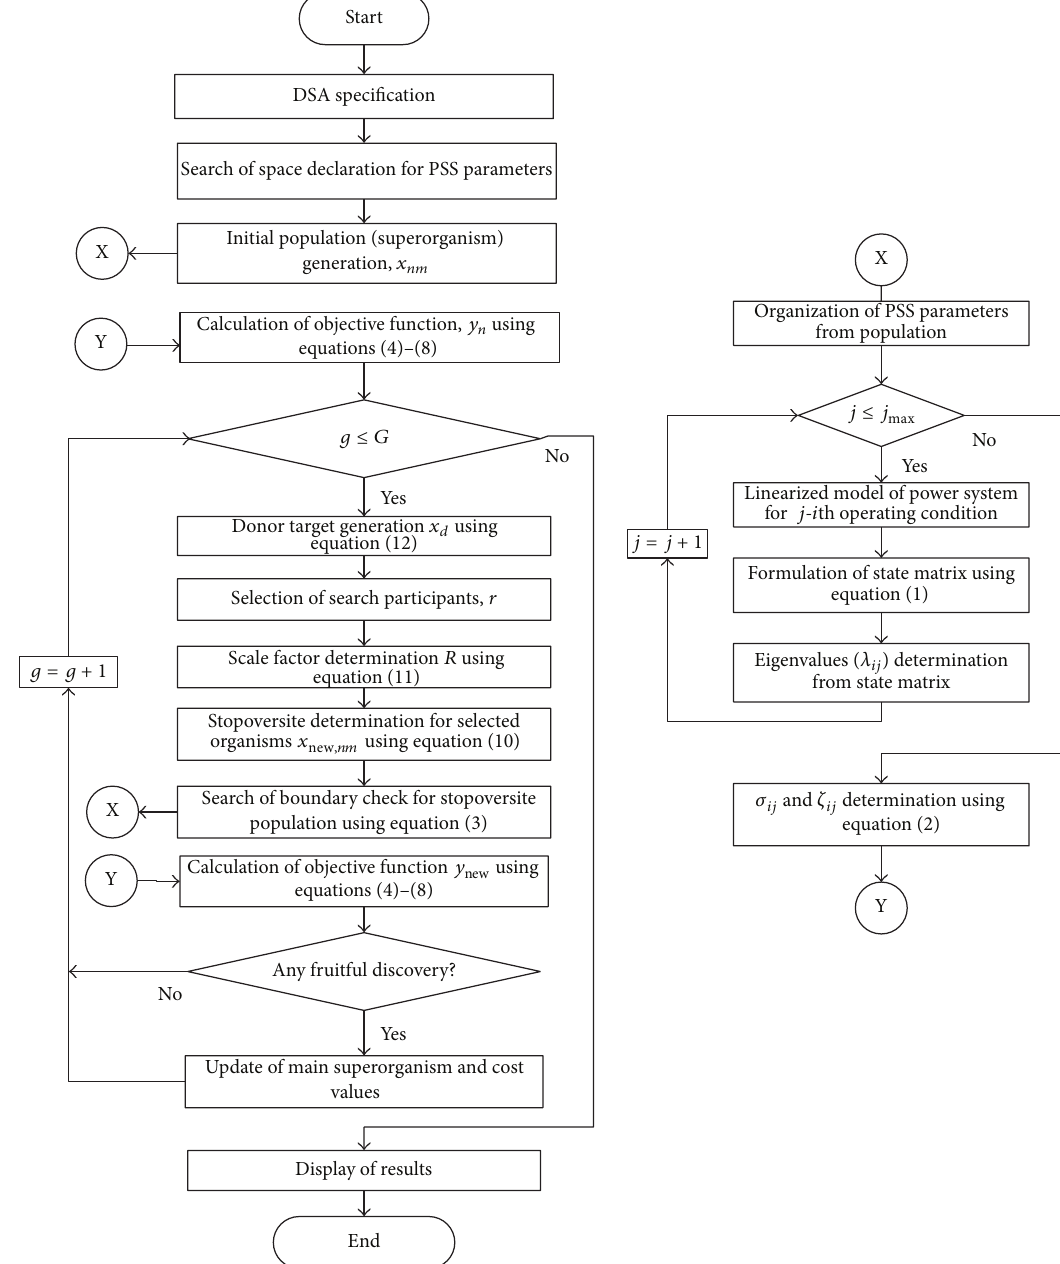
Figure 4: Flow chart of PSS parameters optimization with different objective functions using